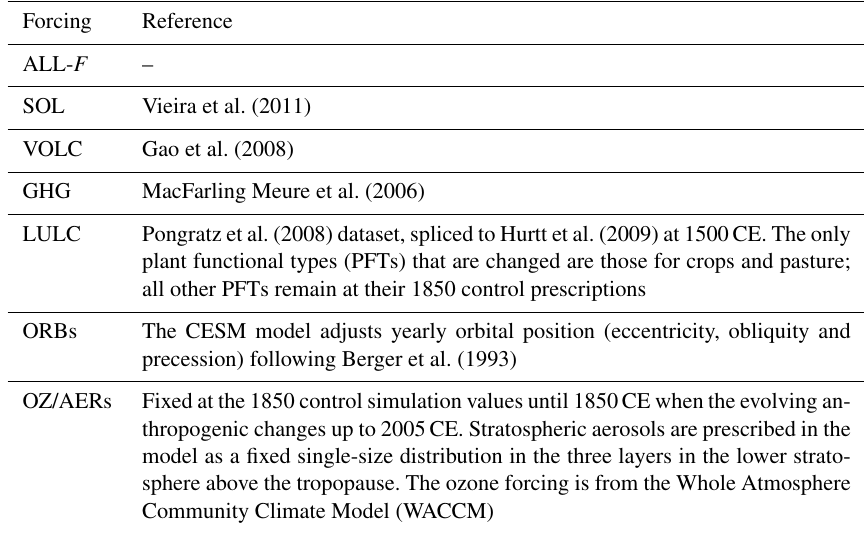
thropogenic changes up to 2005CE. Stratospheric aerosols are prescribed in the model as a fixed single-size distribution in the three layers in the lower strato- sphere above the tropopause. The ozone forcing is from the Whole Atmosphere